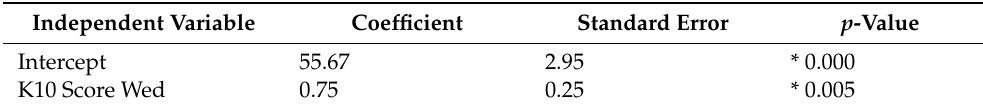
Table 2. Regression result of MASQ Wednesday scores (dependent variable) and K10 Wednesday scores (independent variable). * p <